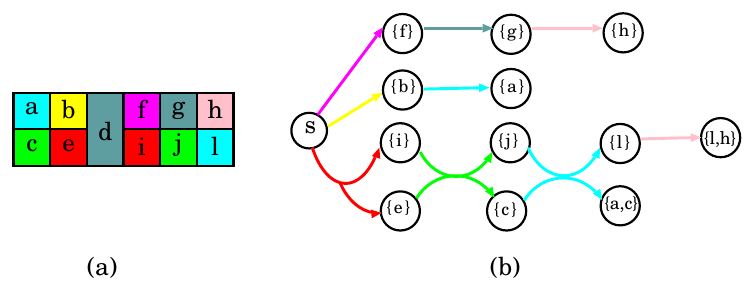
Fig. 3: (a) A 2 × n d -board B . (b) A subgraph of the hypergraph H obtained from B